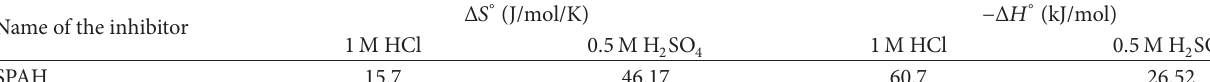
T 4: Some thermodynamic parameters